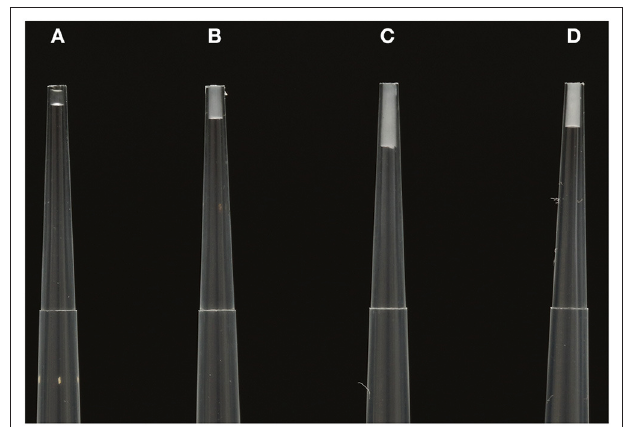
FIGURE 2 | From (A–D) –consecutive venom secretions collected from Hormurus waigiensis during one milking event using electrostimulation of the venom gland. (A) The initial secretion is relatively clear, containing the compositionally simple prevenom. (B) The secretion changes from clear to milky (C,D) . The later venom secretions are comparatively opaque and white, representing the peptide/protein rich mixture. Photograph by Edward Evans.